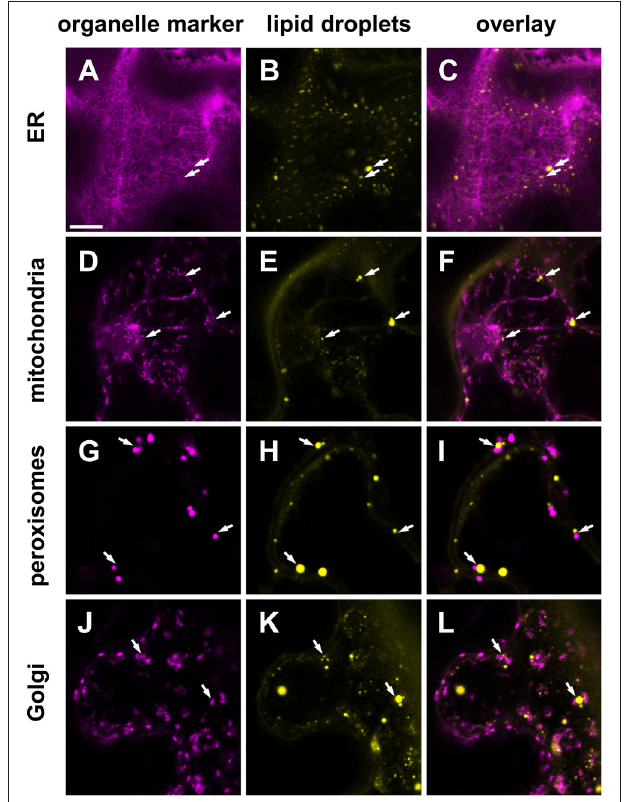
FIGURE 9 | Subcellular localization of LDs (yellow) in Nicotiana benthamiana leaves transiently expressing various organelle markers (magenta). Markers for the endoplasmic reticulum (ER, A–C ) mitochondria (D–F) , peroxiosomes (G–I) , or the Golgi apparatus (J–L) , fused to mCherry were co-infiltrated with P19, DGAT1, WRI1 in the leaves of 5 weeks old N. benthamiana. Arrows highlight examples of LDs found in the vicinity of marked cellular organelles. Scale bar in (A) = 10 µ